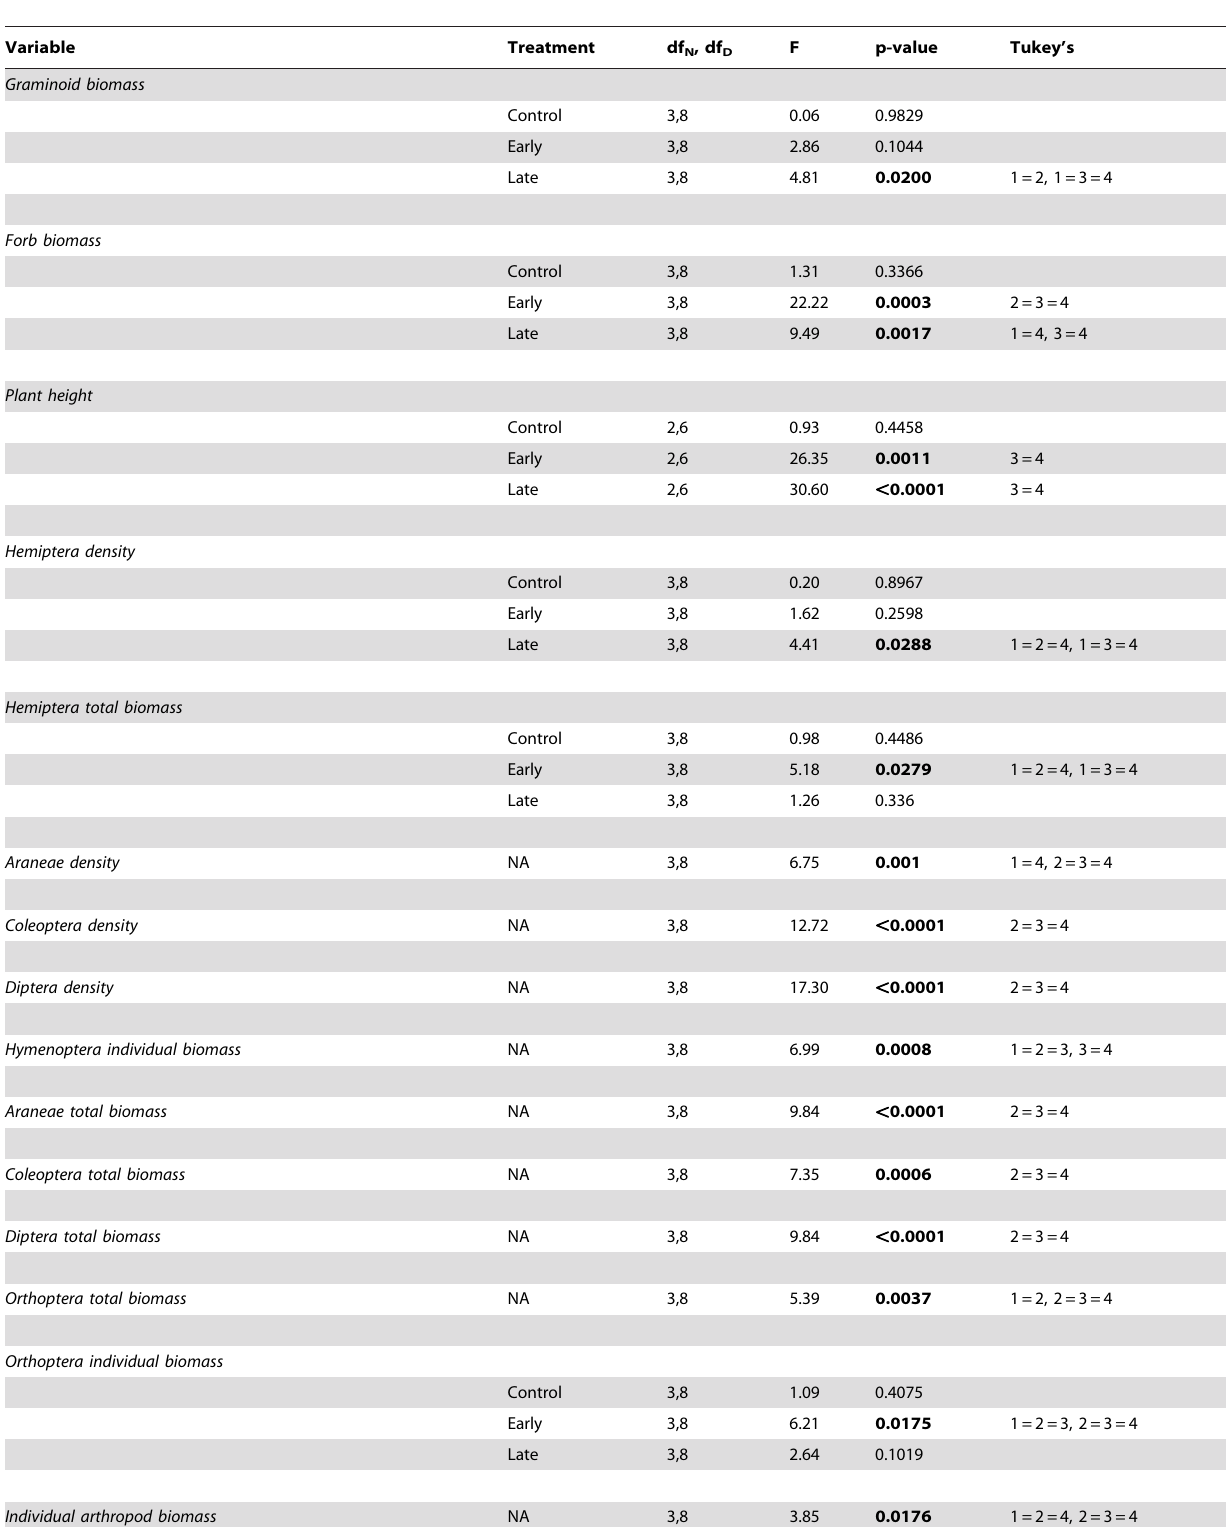
Table 3. Univariate one-way ANOVAs for each treatment and Tukey’s Honestly Significant Difference multiple comparisons when a significant sampling event effect was present within each treatment for upland grasslands